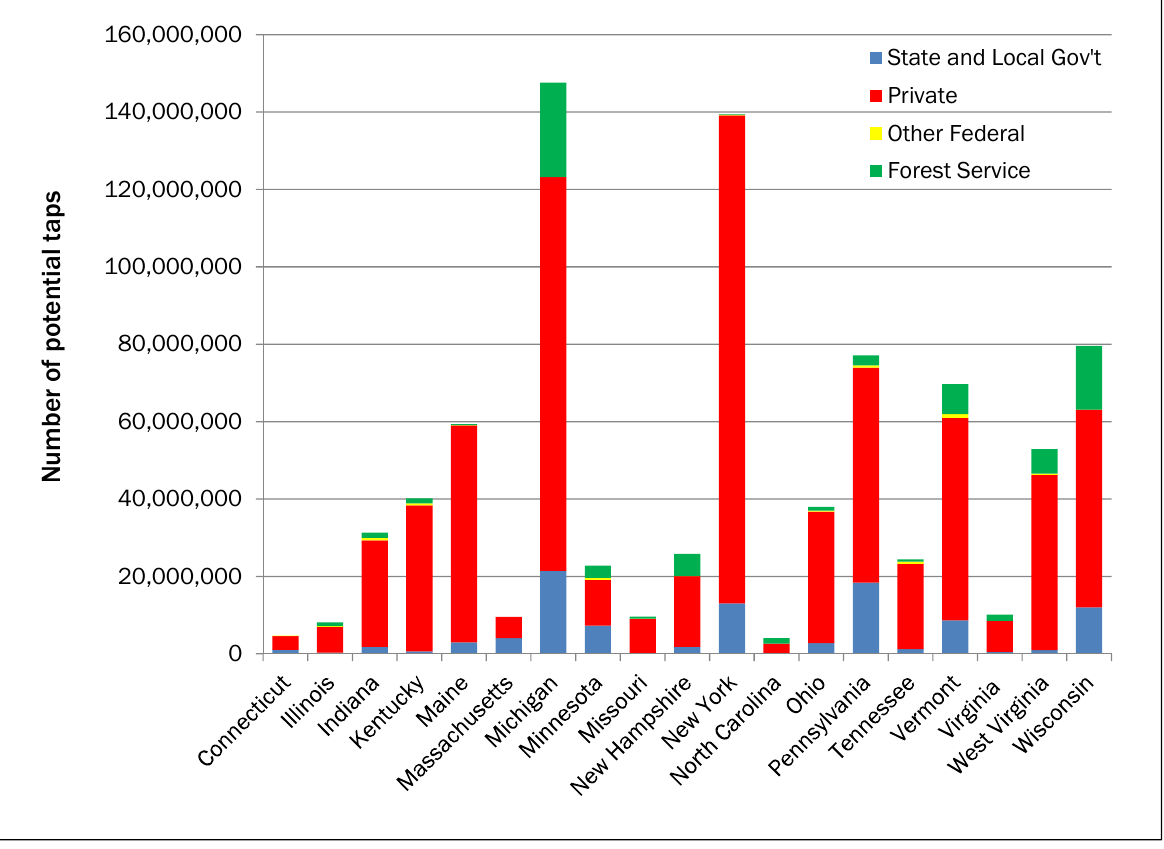
Source: U.S. Department of Agriculture, Forest Service.